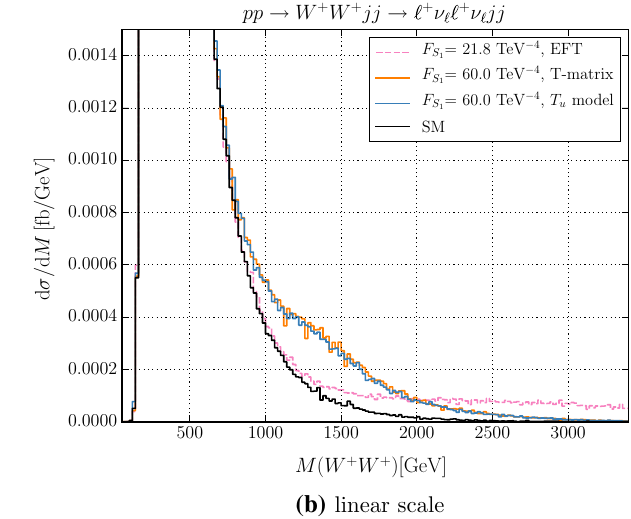
F S 1 anomalous coupling using the present CMS upper limit. The solid orange and blue lines show the a unitarized curve with the same fiducial cross section as the EFT curve using the T-matrix and the T u model, respectively. Cuts defining the fiducial region are given in Eq.